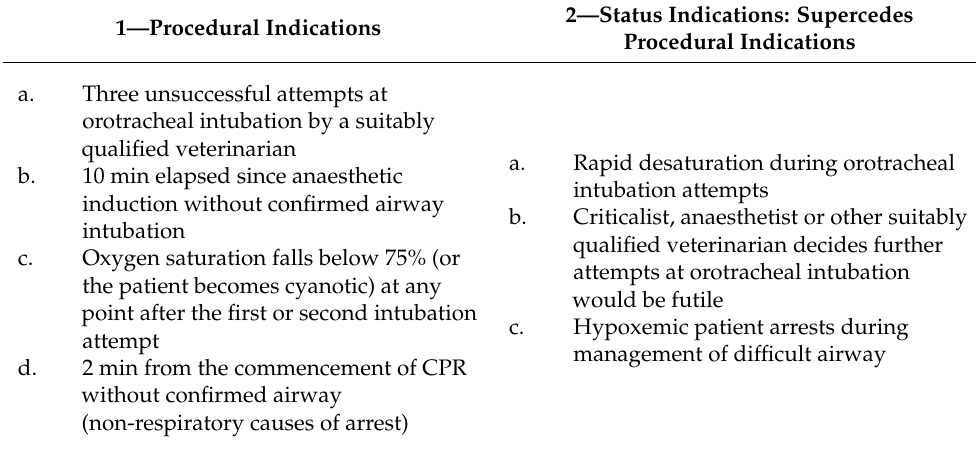
Table 1. Proposed guidelines for diagnosis of cannot intubate, cannot oxygenate and indications for emergency front of neck airway access in small animals during difficult airway